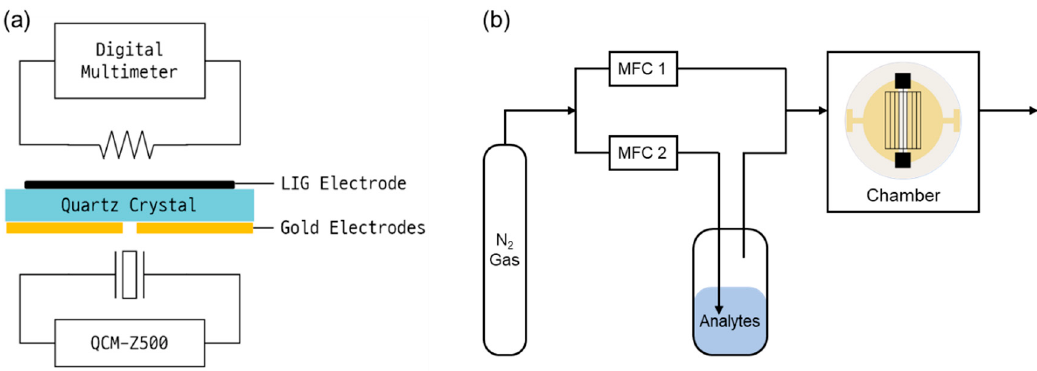
Figure 2. Schematic diagrams of the instrumental setups. ( a ) electrical connections for the QCM and resistance measurement. ( b ) setup for gas sensing.